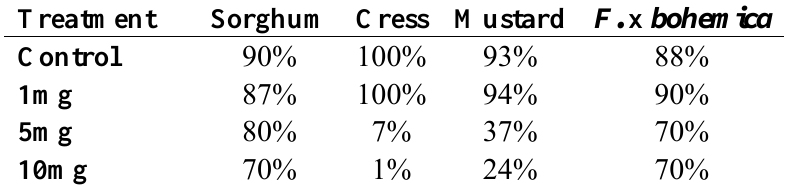
Table 1. Effects of M. gale methanol fruit exudate extracts on the germination rates of sorghum, cress, mustard and F. x bohemica . Concentrations are the total quantities of dry exudate extracts added to each Petri dish. Thirty plants were used for each treatment.